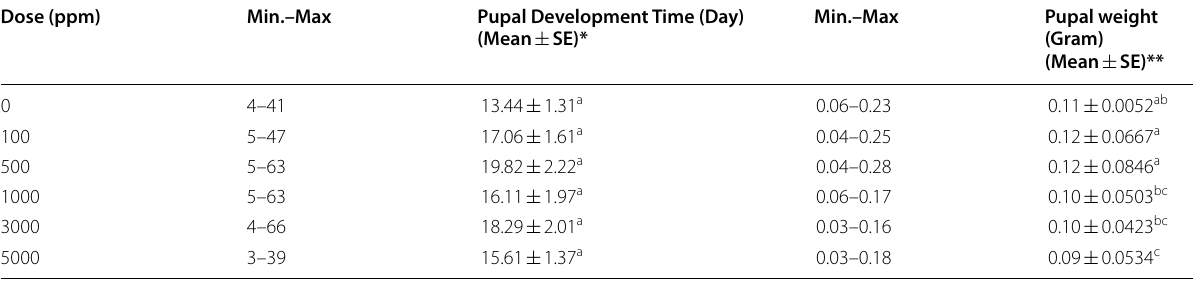
*Kruskal Wallis, P > 0.05